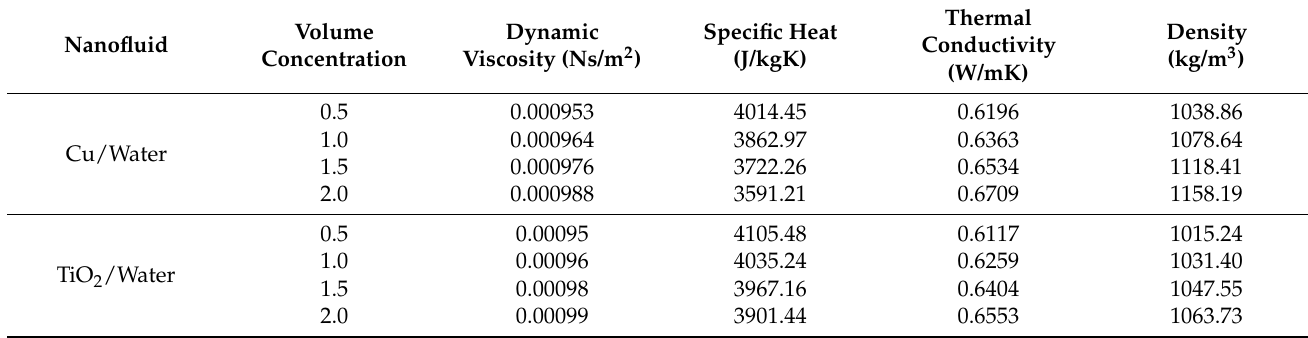
Table 2. Thermal-fluid properties for